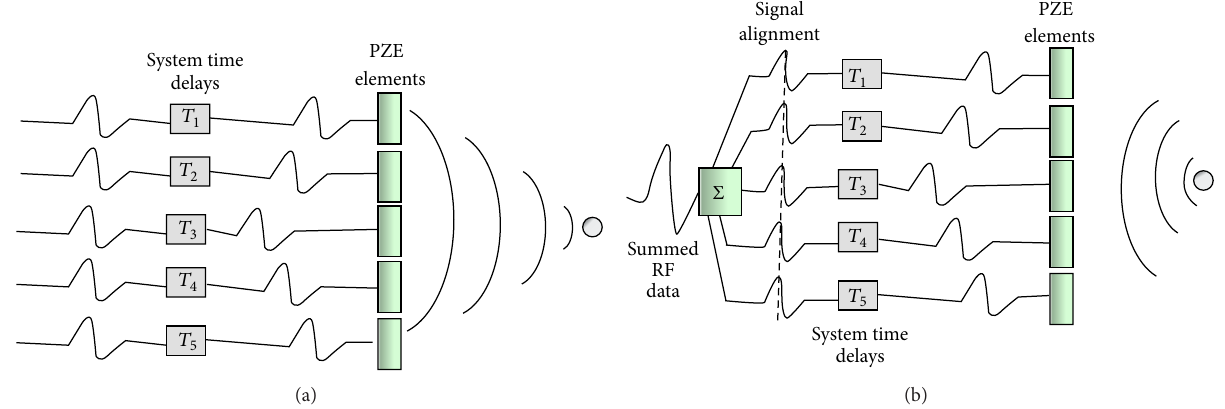
Figure 2: Schematic drawing of beamforming using a conventional 2D phased array transducer. During transmission (a), focused beams of ultrasound are produced by pulsing each piezoelectric element with precalculated time delays (i.e., phasing). During reception (b), focusing is achieved by applying selective delays at echo signals received by the different piezoelectric elements in order to create isophase signals that will be summed in a coherent way.